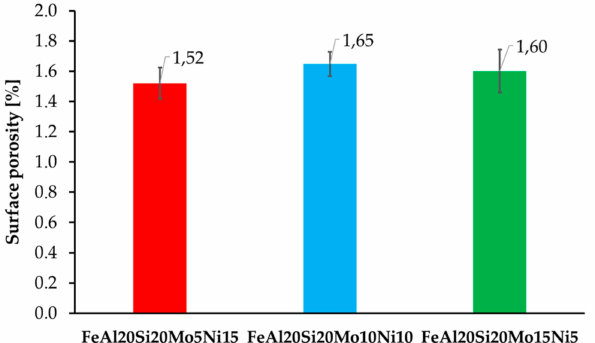
Figure 2. Surface porosity of the prepared MA + SPS FeAl20Si20-Mo-Ni alloys depending on the actual content of Mo and Ni within the